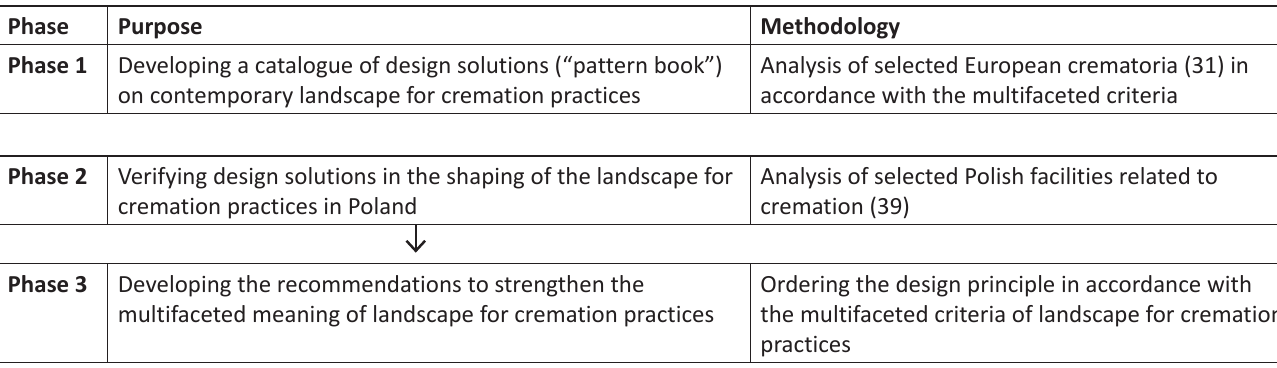
Figure 6. Research